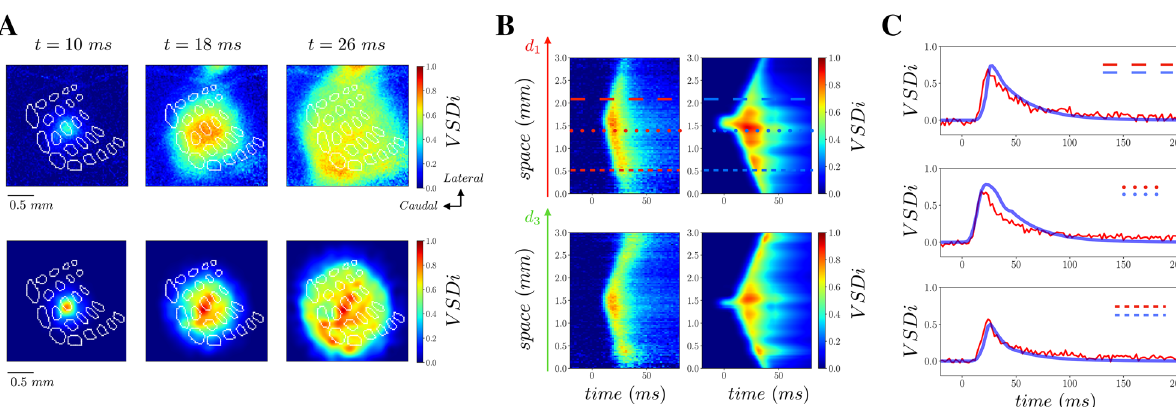
Figure 4. Inference from experimental data. (A) Time frames of VSD activity evoked by a C2 whisker stimulus (at t = 0 ms) from data (top row) and from the model with reconstructed couplings (bottom row). ( B ) Spatio- temporal linescan plots computed from data (left) and the model (right) for two different spatial segments (see Fig. 1C). ( C ) Time traces of VSD activity (normalized to its maximum in space and in time) in time at the three spatial location marked as dashed, dotted and densely dashed lines marked in (B) . Red (blue) solid line are from experimental data (computational